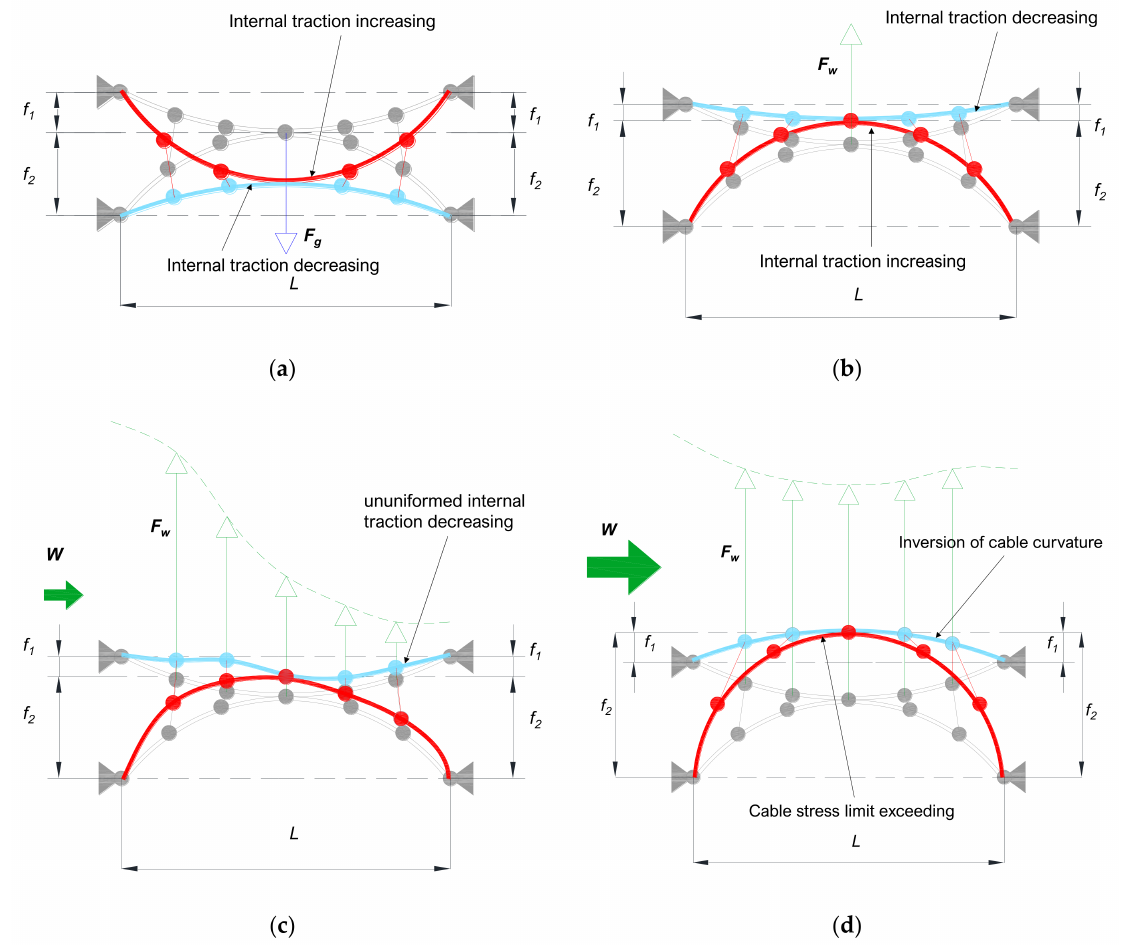
Figure 1. Structural behavior: gravitational load ( a ), suction ( b ), ununiformed suction ( c ), extreme suction ( d